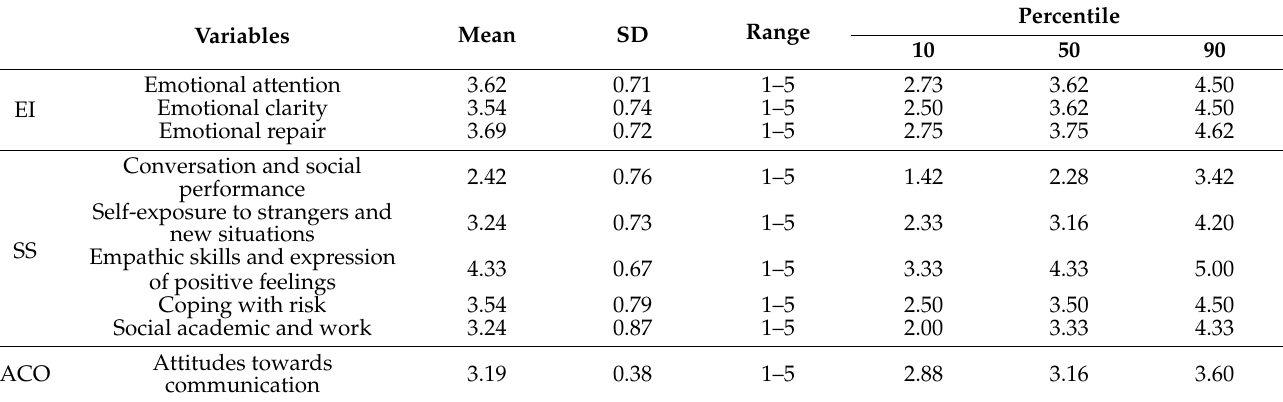
Table 2. Descriptive statistics for